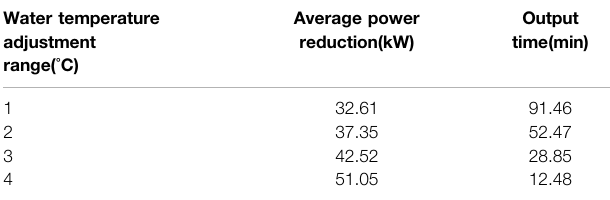
TABLE 2 | The output characteristic points of virtual